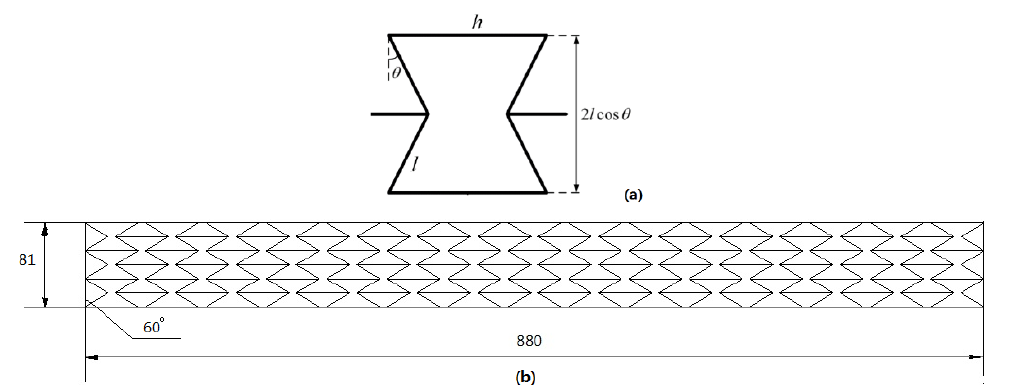
Figure 3. Cell configuration and design of the auxetic re-entrant blast wall (ARBW). ( a ) auxetic unit cell, ( b ) auxetic layout.